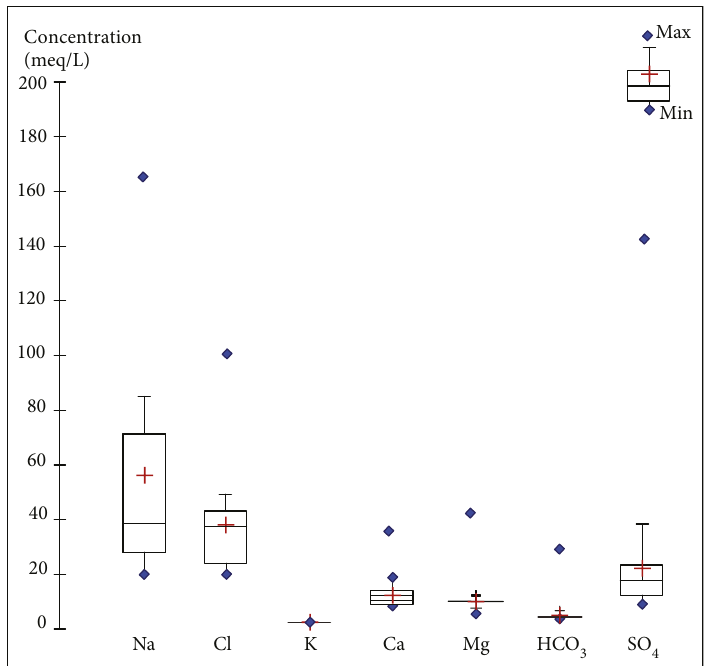
dissolved versus NO 3- (a), NH 4+ (b), and NO 2- (c). Bivariate plot of H 2